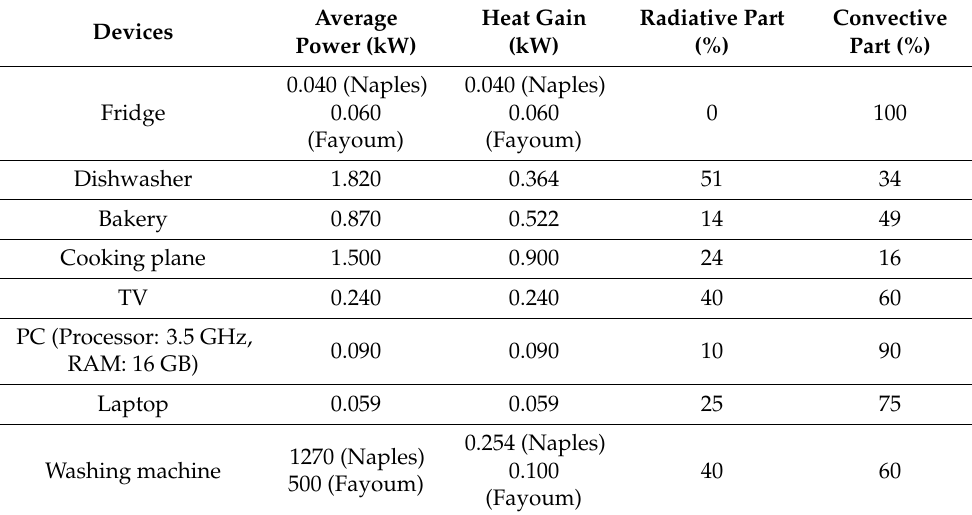
Table 5. The heat gain features of the appliances and devices